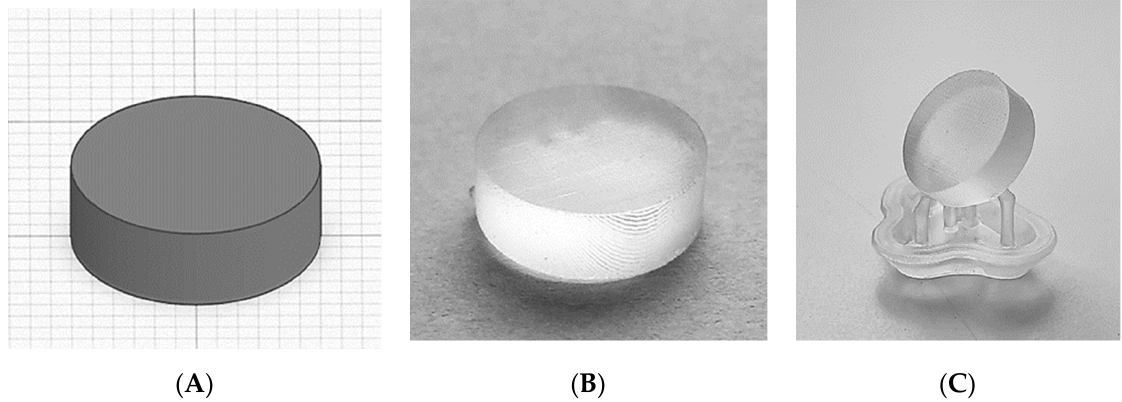
Figure 8. ( A ) CAD model and ( B ) 3D printed cylindrical tablet printed directly on the build platform. ( C ) Tablet 3D printed using supports.